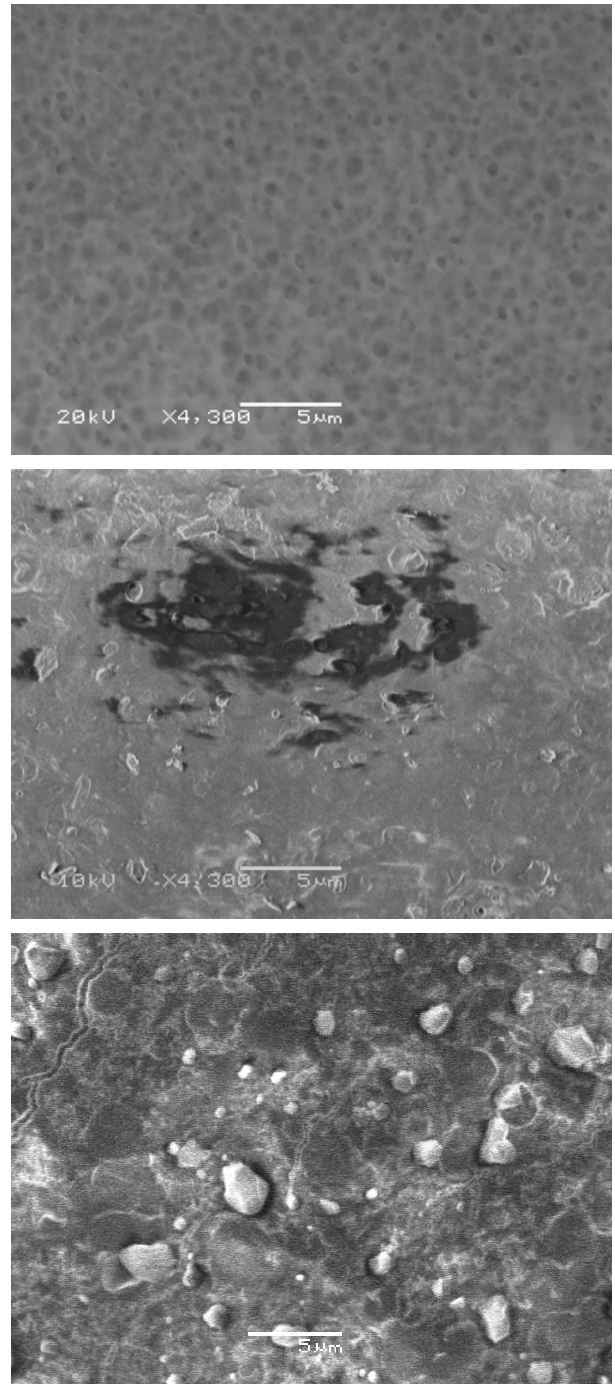
Figure 7. Representative SEM micrographs of polysulfone membranes. TOP: clean with the porous surface clearly visible; MIDDLE: fouled with 0.1 g/L BSA; BOTTOM: fouled with 0.1 g/L amylase. Original magnification: